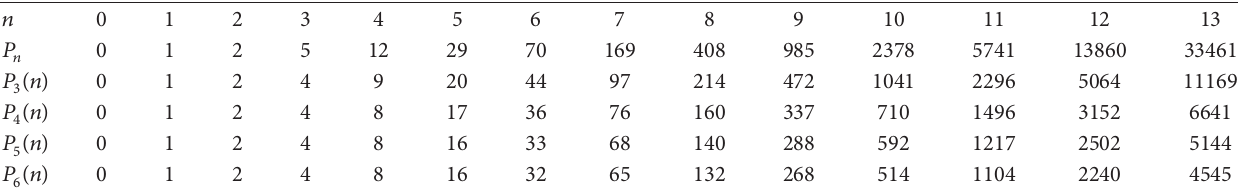
Table 1: The 𝑘 -distance Pell sequence 𝑃 𝑘 (𝑛) .